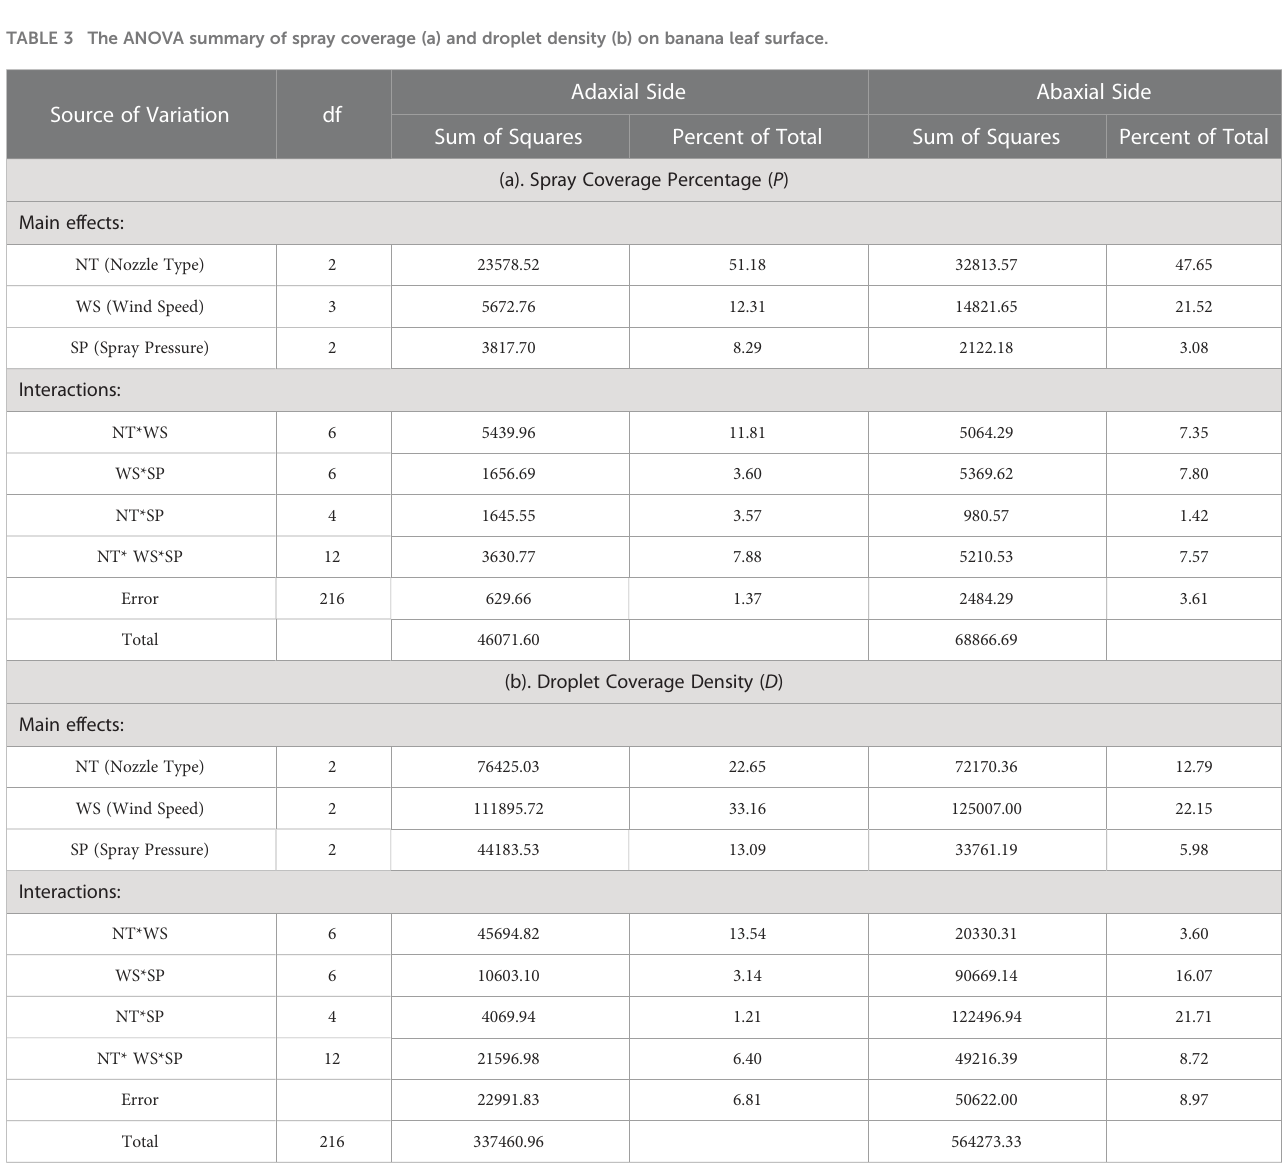
TABLE 3 The ANOVA summary of spray coverage (a) and droplet density (b) on banana leaf surface.